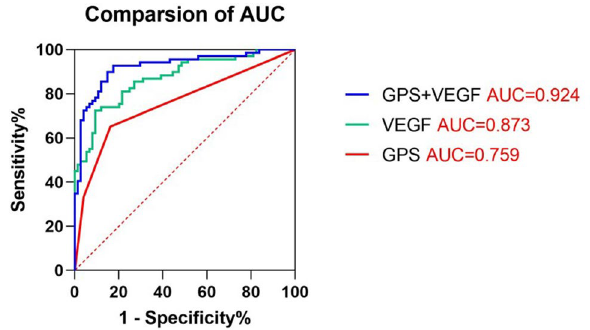
Figure 5. Comparison of the AUCs for prognostic prediction of combined detection of VEGF and GPS (AUC = 0.924, p < 0.0001), VEGF (AUC = 0.873, p < 0.0001), GPS (AUC = 0.759, p < 0.0001) 3 months after radiotherapy for ESCC patients. The red entries represent statistically significant.